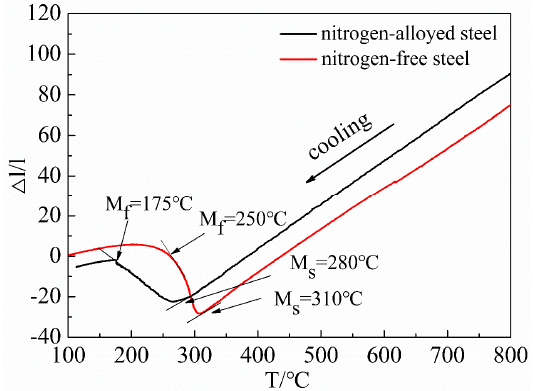
Figure 8. Transition temperatures of samples steels during quick cooling treatment ( Δ l and l are expansion length and original length of samples, respectively).